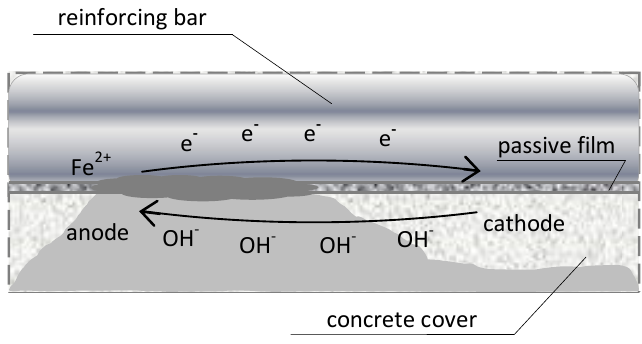
Figure 1. Reinforcement corrosion process in concrete.